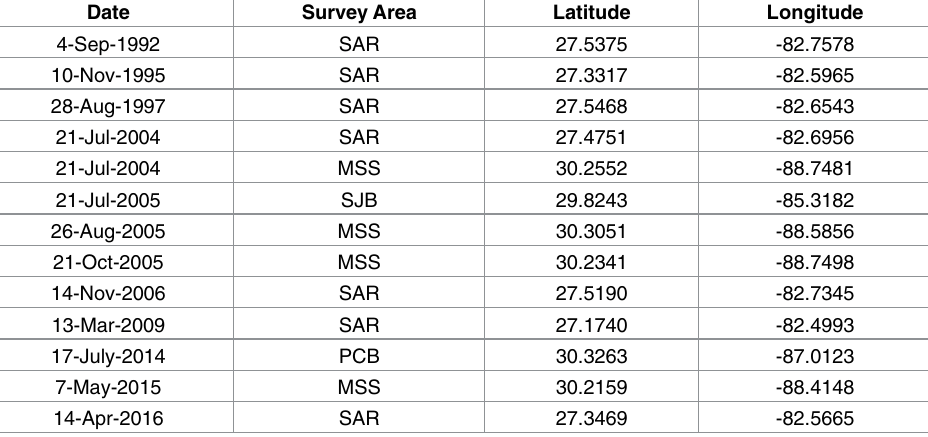
Table 1. Bottlenose dolphin sightings (n = 13) associated with catfish decapitation in the nGoMx. MSS = Mississippi Sound, PCB = Pensacola Bay coast, SJB = Saint Joseph Bay, SAR = Sarasota Bay and west Florida